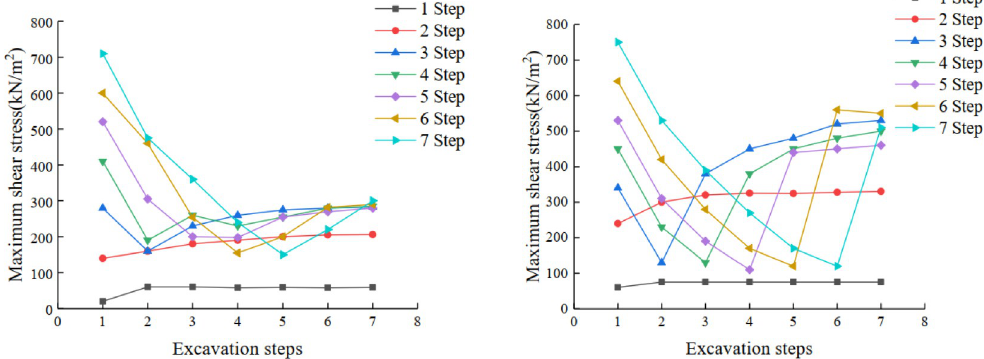
Fig 14. (a). Maximum shear stress curve of each step during slope excavation (in the middle of slope). (b). Maximum shear stress curve of each step during slope excavation (at the top of the